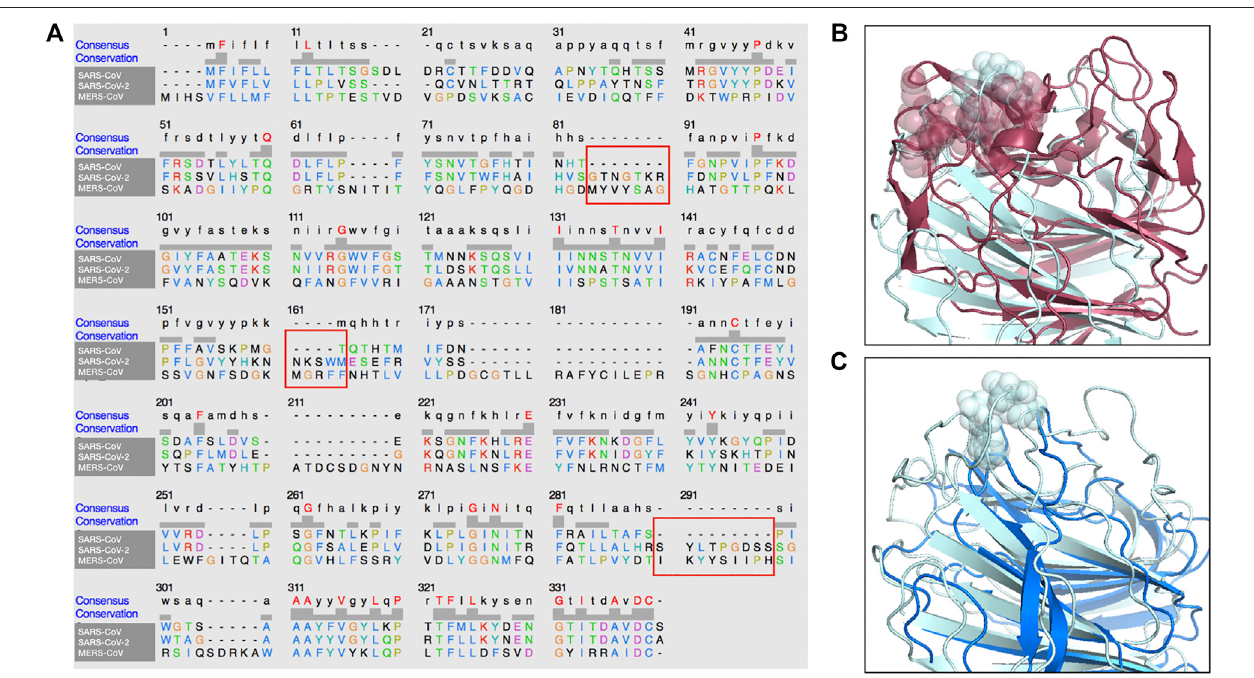
FIGURE 4 | Sequence and structure comparison of the N-terminal region of MERS-CoV, SARS-CoV-2 and SARS-CoV. (A) A multiple sequence alignment between the MERS-CoV, the SARS-CoV and the SARS-CoV-2 spike protein sequence. (B) Structural comparison between MERS-CoV and SARS-CoV-2 A-domain. The three segments of the sialic-acid binding site for MERS-CoV spike and the proposed binding site on SARS-CoV-2 spike are highlighted. (C) Structural comparison between SARS-CoV and SARS-CoV-2 A-domain. The proposed binding site on SARS-CoV-2 has no corresponding structure in the SARS-CoV